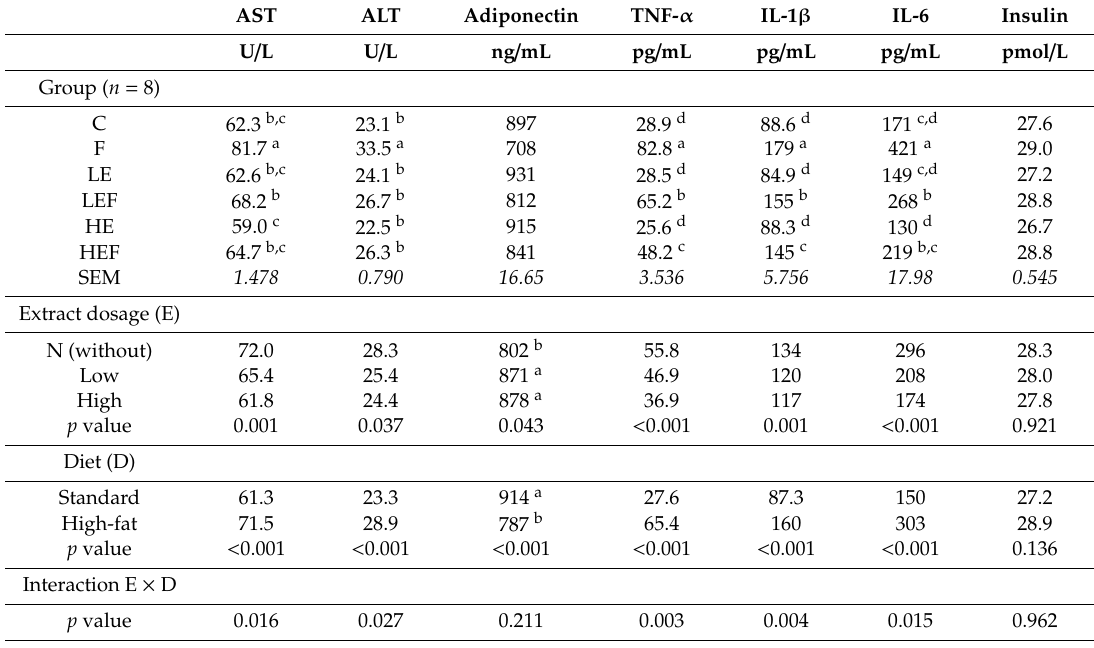
Table 4. Biochemical indicators of the blood serum of rats fed the experimental diets